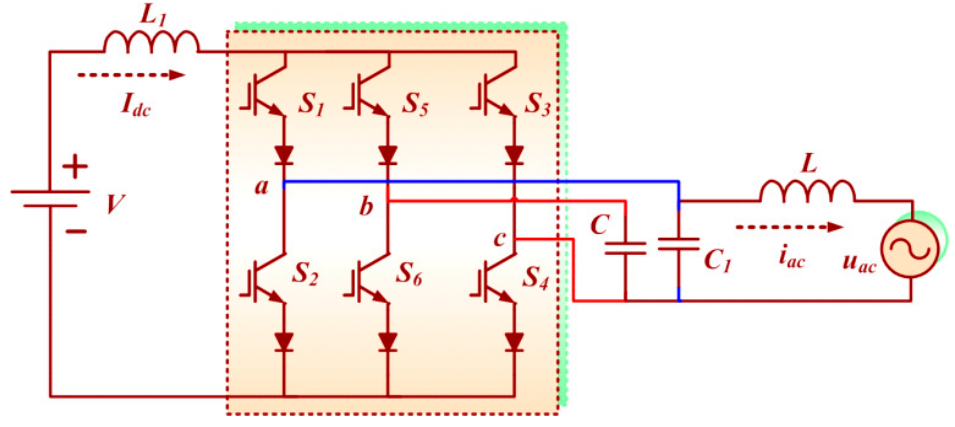
Figure 10. Power decoupling solution in [36].